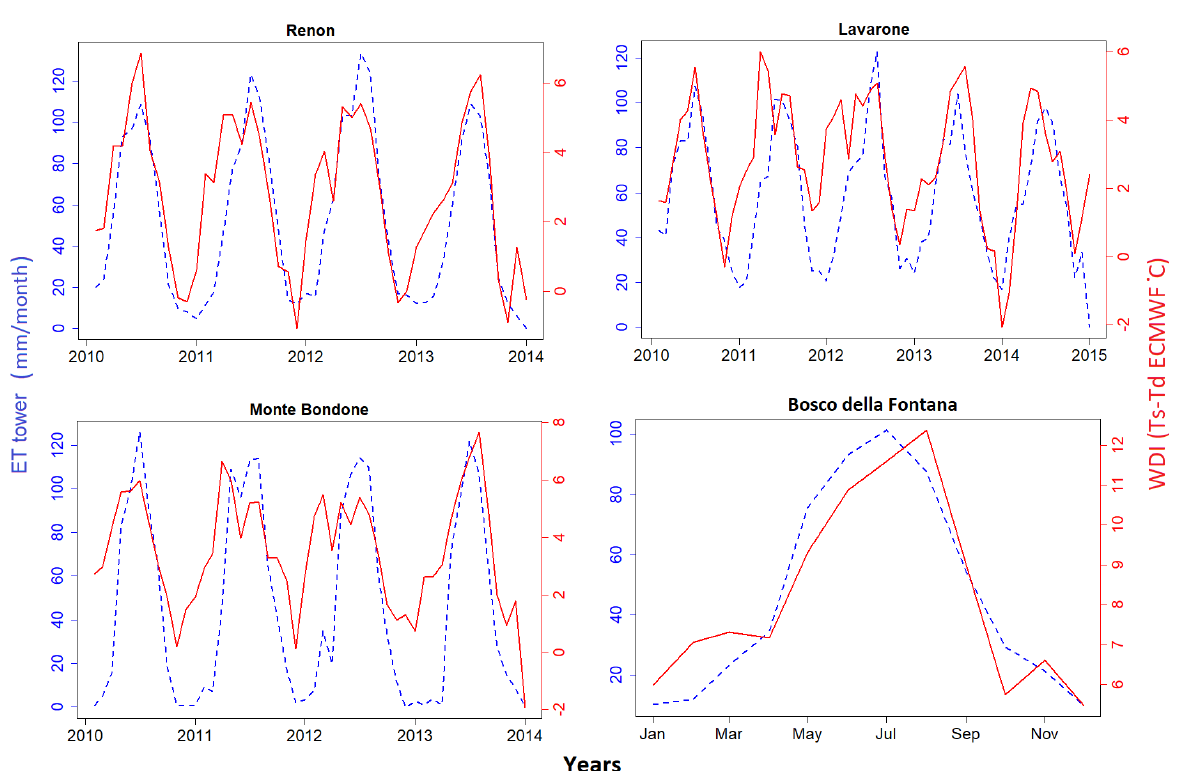
Figure 5. Time series of ET (blue dashed line) and WDI (red